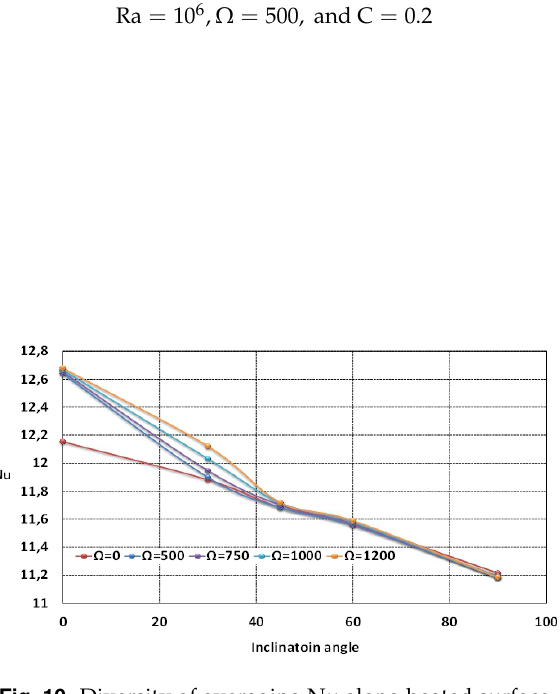
Fig. 10. Diversity of averaging Nu along heated surface with inclination angles, Ra =10 6 , and